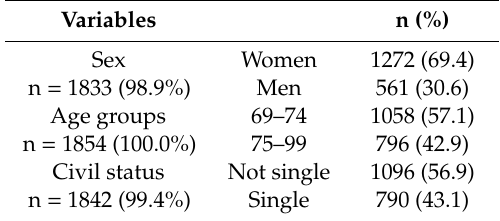
Table 1. Demographic characteristics of the study population, number and percentages (n,